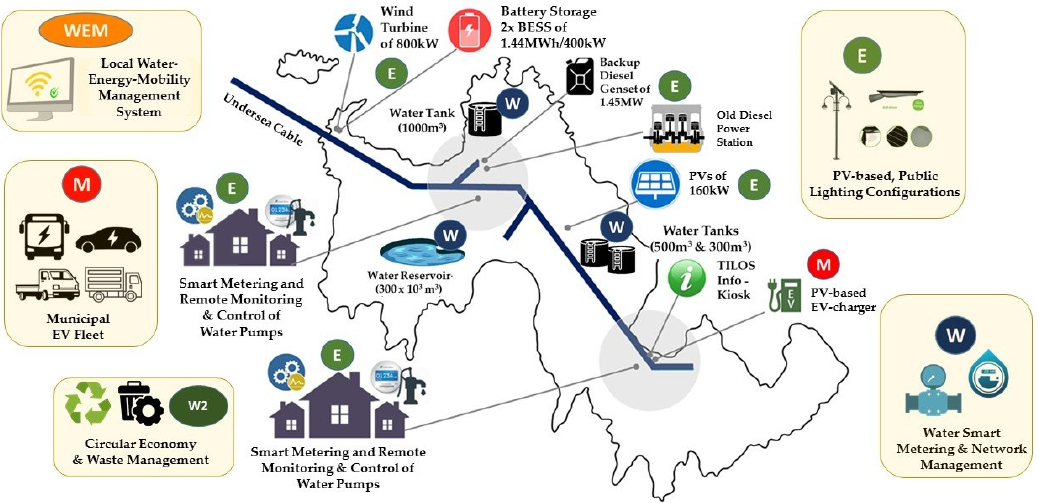
Figure 11. Tilos’ microgrid layout.